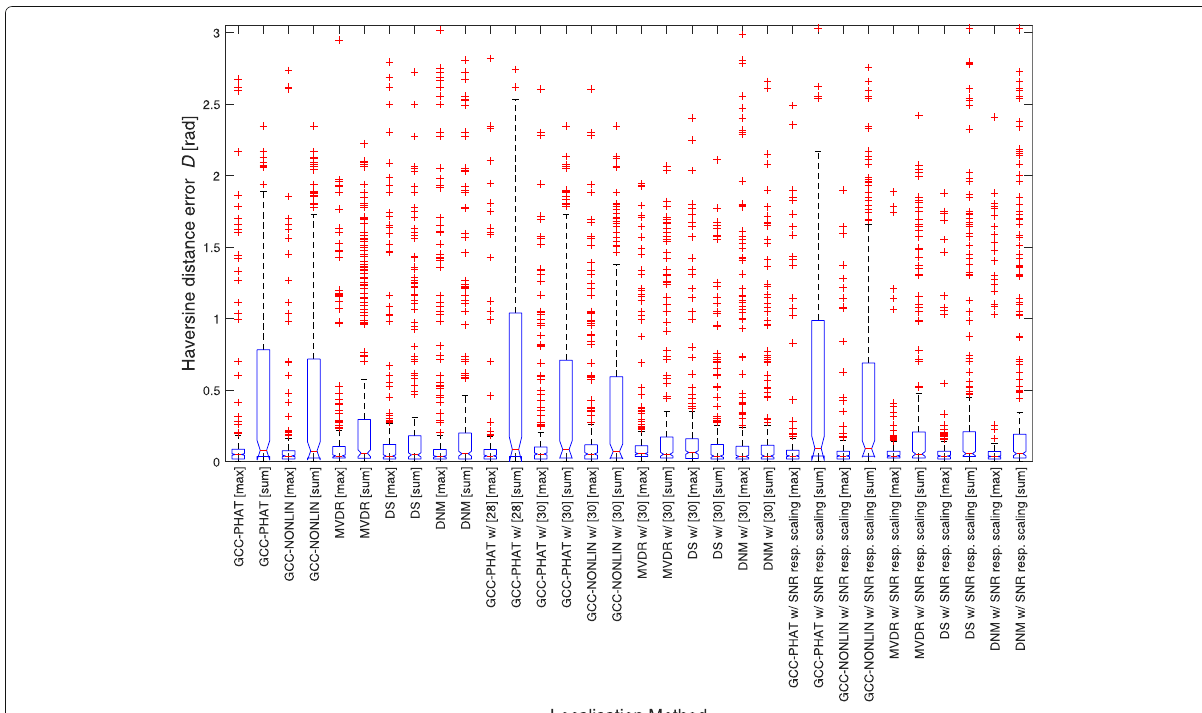
Fig. 8 Hovering UAV (task 1)—haversine distance error distribution. Red line indicates the median, upper and lower edges of the blue box indicate the 75% and 25% quartiles, upper and lower black bars indicate the maximum and minimum, and upper and lower corners of the trapezoidal indicate the 95% upper and lower confidence limits